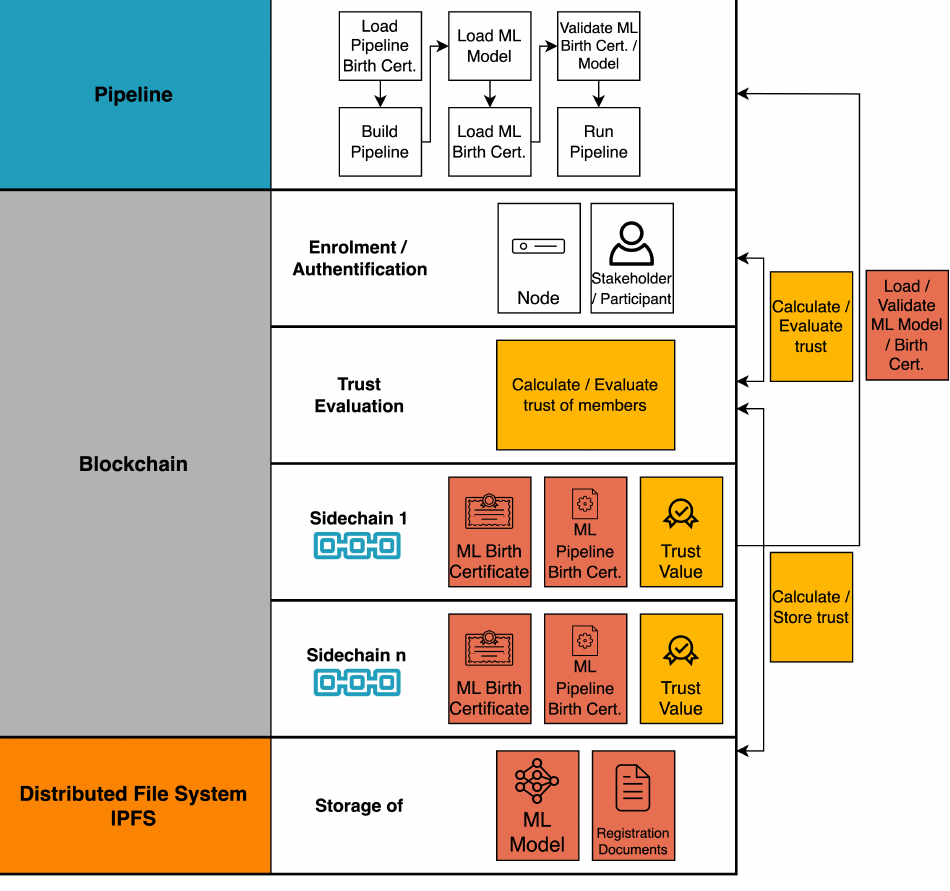
Figure 1. System